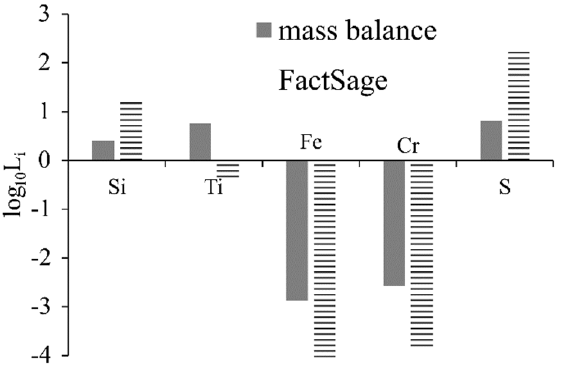
Figure 13. Distribution coefficient (L i ) of Si, Ti, Fe, Cr, and S between mass balance and FactSage assumptions, in logarithmic